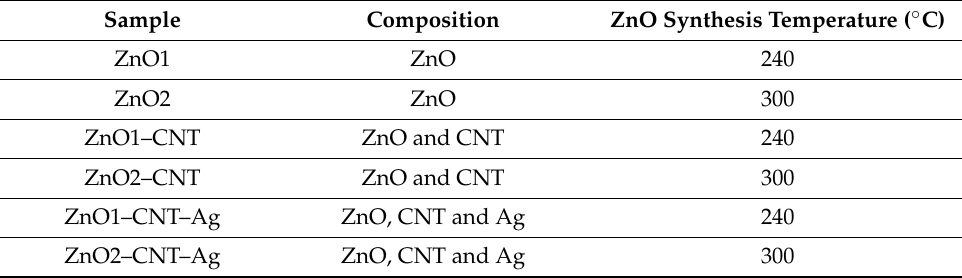
Table 1. List of samples, their composition and synthesis temperature of ZnO